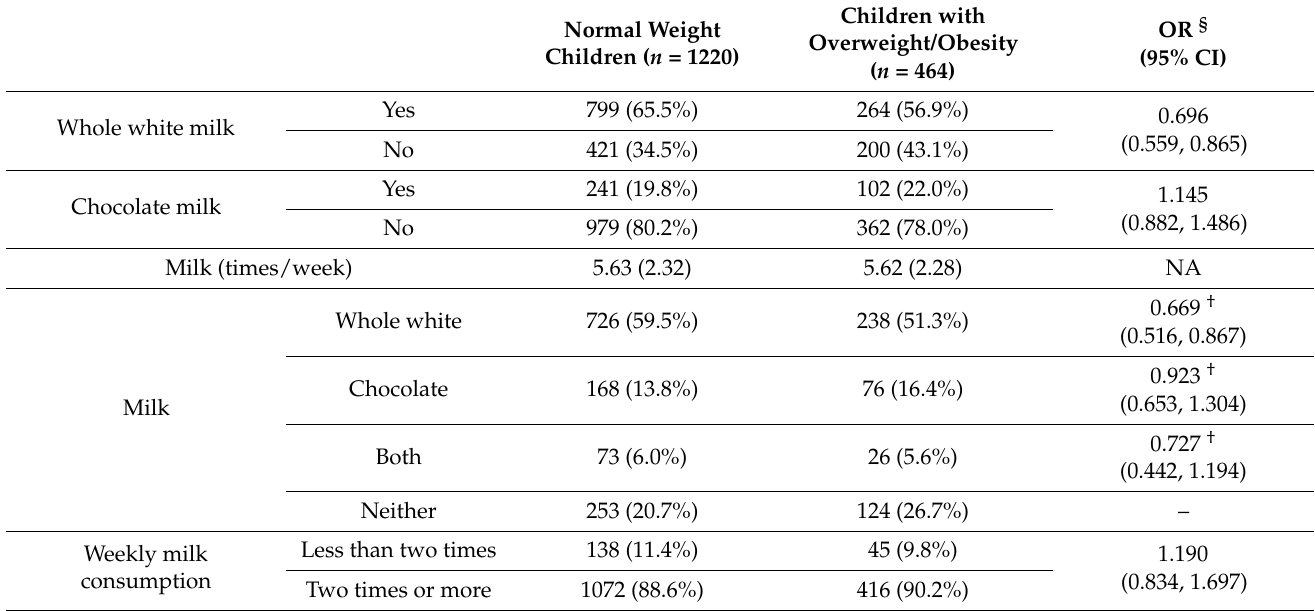
Table 3. The association between type of milk and weight status. Children with Normal Weight Children ( n = 1220)